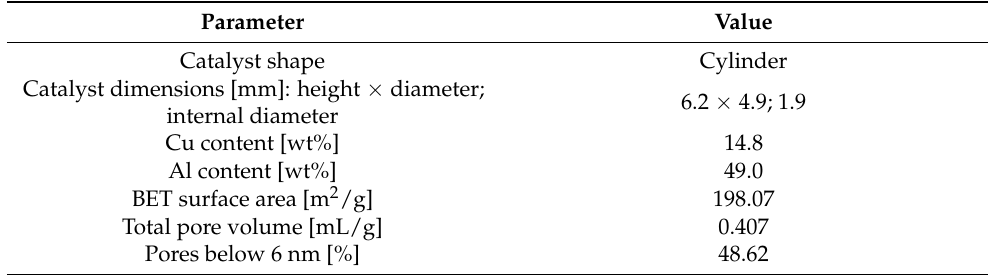
Table 5. Fresh Cu-based catalyst prepared with calcined support impregnated in a 20 wt% solution description, XRF analysis and BET analysis results.